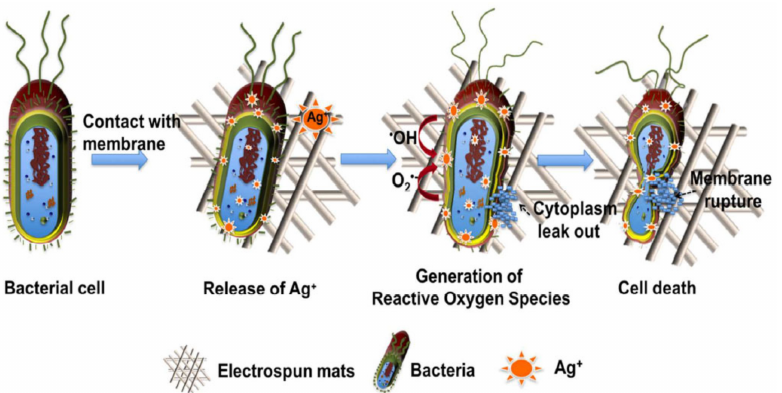
Figure 7. Schematic diagram of the release of Ag + ions from AgNPs comprising PLA electrospun membranes exhibiting antibacterial properties. Reprinted with permission from Ref. [201]. Copyright 2017, American Chemical